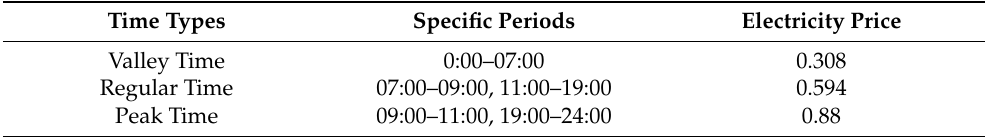
Table 1. Time-of-use electricity price data from